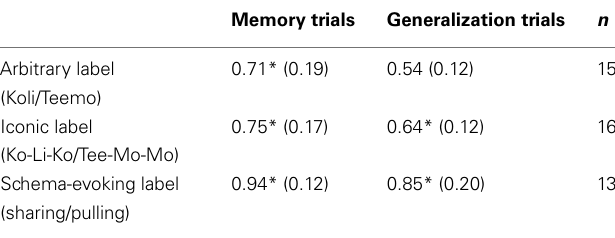
Table 1 | Means (and SDs) from the label conditions tested in Experiment